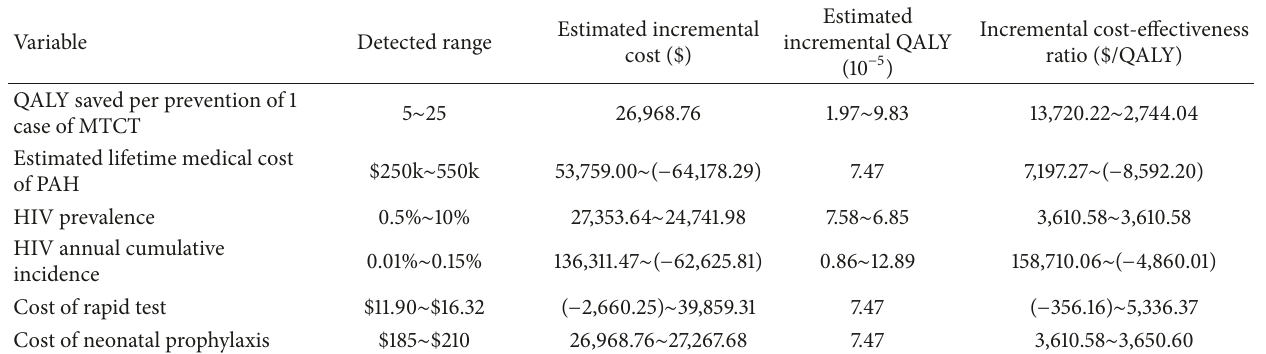
Table 6: Univariate sensitivity analysis of universal rapid HIV screening relative to standard of care II.